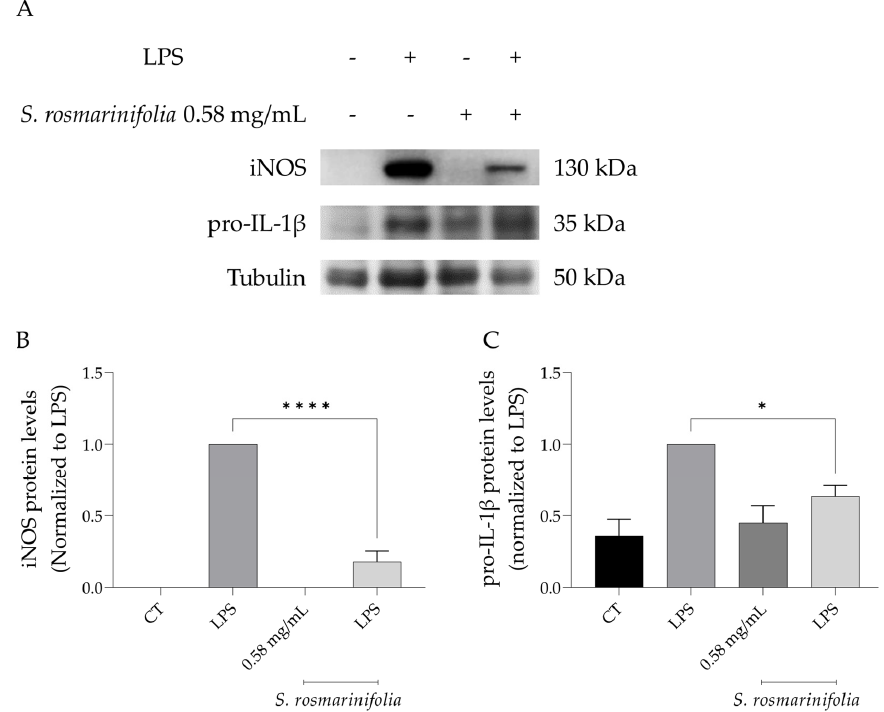
Figure 6. Santolina rosmarinifolia essential oil decreased iNOS and pro-IL-1 β protein levels. ( A ) Rep- resentative western blot for iNOS and pro-IL-1 β . ( B ) Relative protein levels of iNOS. ( C ) Relative protein levels of pro-IL-1 β . Results show the mean ± SEM of three independent assays made in du- plicate. Protein levels were normalized to tubulin and to LPS. * p < 0.05 and **** p < 0.0001 when compared to LPS (Lipopolysaccharide).